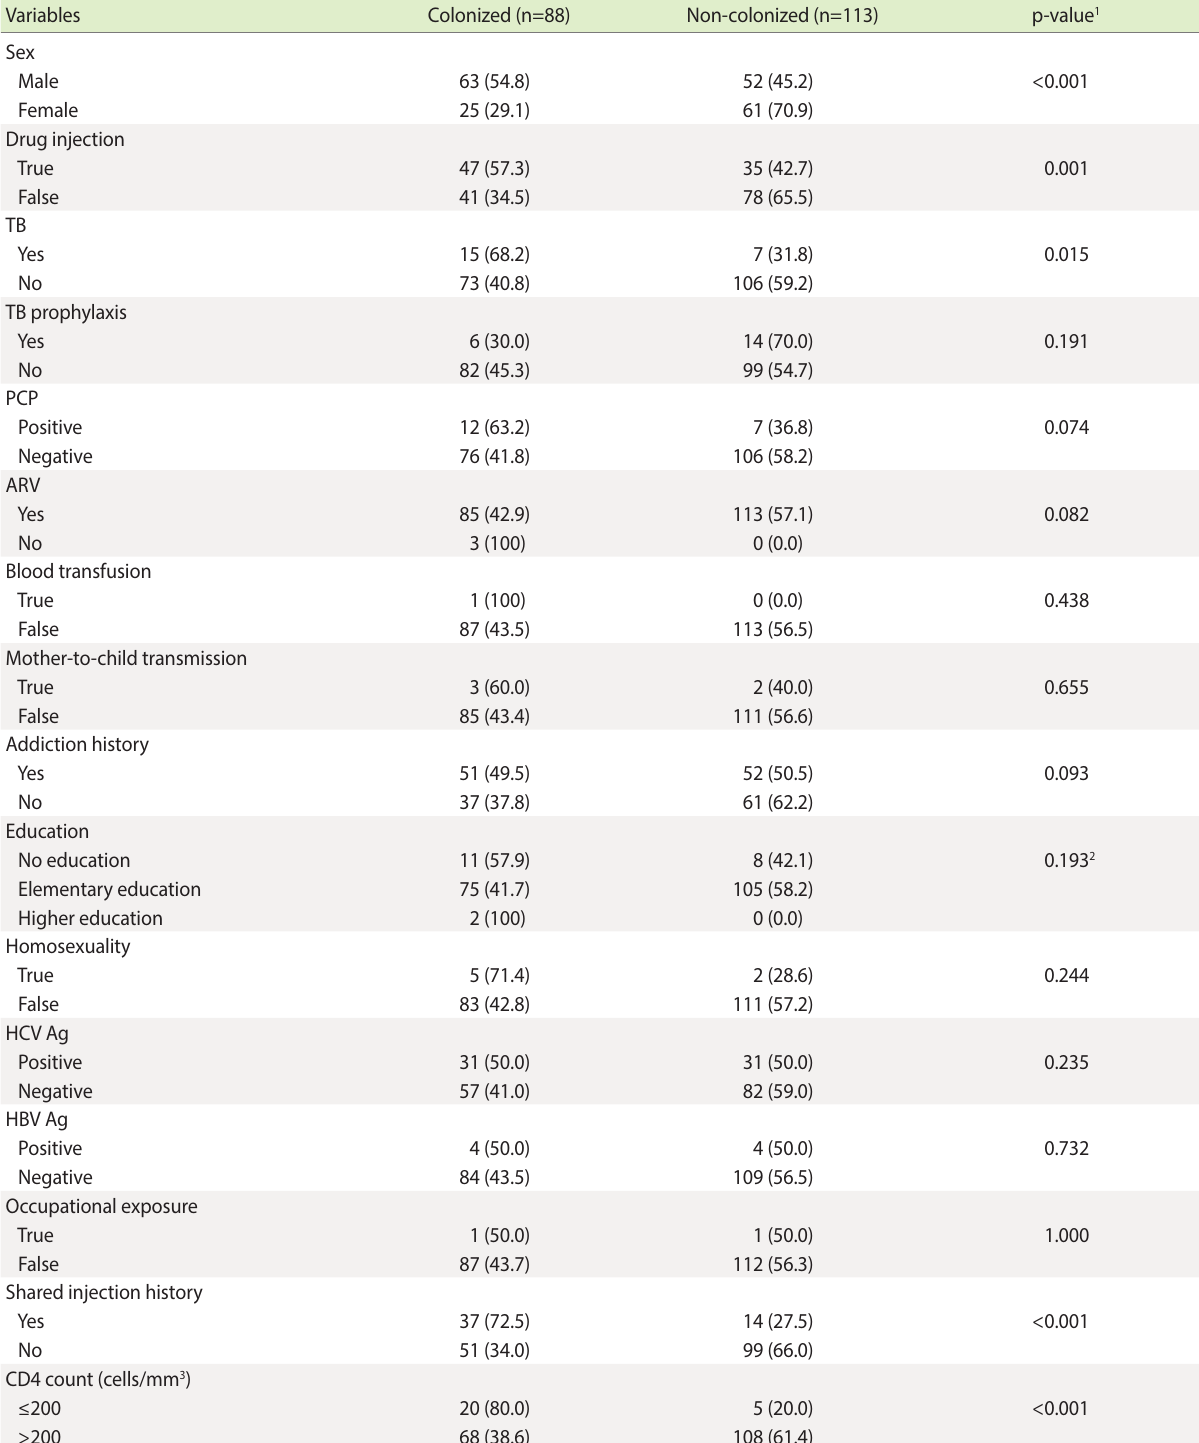
Table 2. The frequency of socio-demographic characteristics of the study subjects